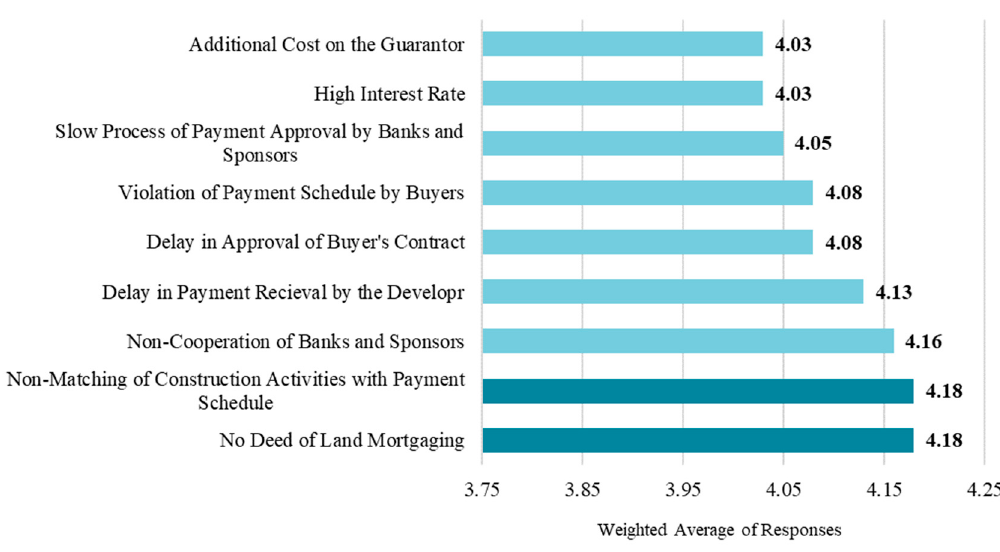
Figure 7. The Weighted Averages of Financial Challenges based on the Consensus of Experts.